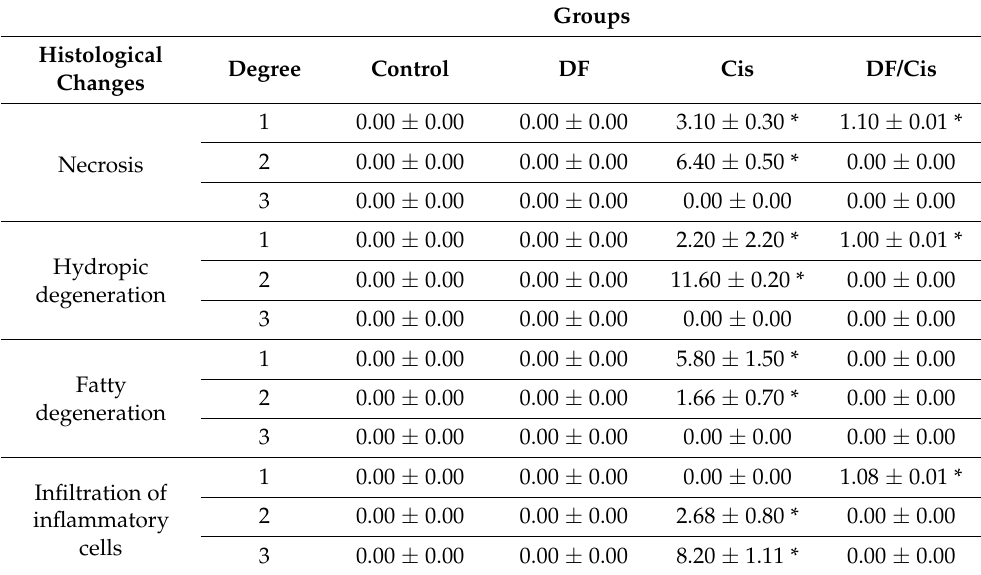
Table 4. Effect of pretreatment with methanolic date flesh extract (MDFE) on the scoring of liver injury in cisplatin-injected